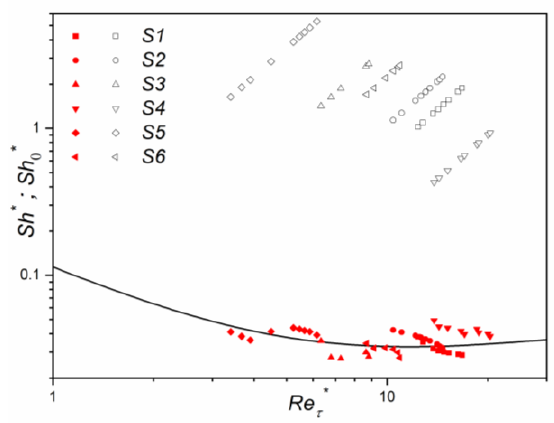
Fig. 2. Onset values of both the usual 𝑺𝒉 𝟎∗ (black open symbols) and the extended 𝑺𝒉 ∗ (red closed symbols) Shields numbers as a function of the critical particle shear Reynolds number 𝑹𝒆 𝝉∗ obtained with the 2D numerical simulations. The solid line stands for the so-called Shields curve